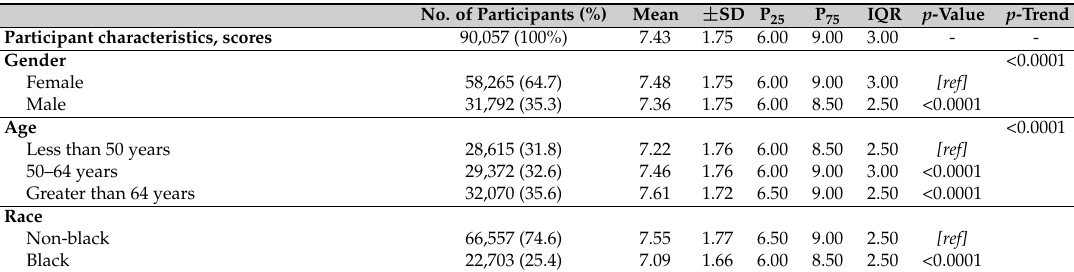
Table 2. Mean VLI score according to selected demographic characteristics in the Adventist Health Study-2 (AHS-2)